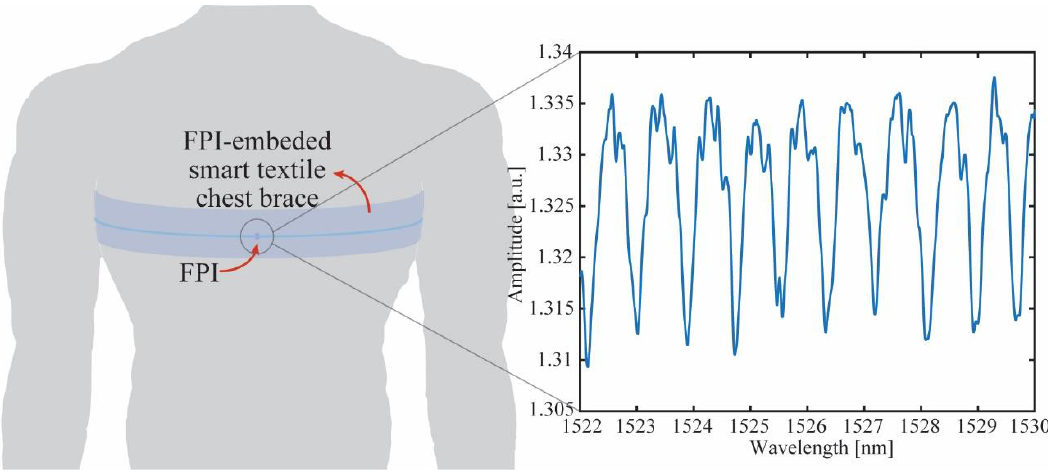
Figure 4. Schematic representation of the FPI-embedded smart textile for simultaneous measurement of breath and heart rates. The inset shows the FPI spectrum acquired by the portable interrogator.